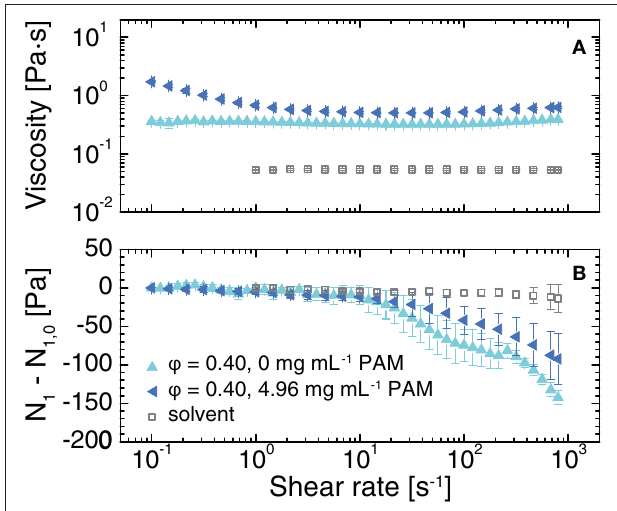
FIGURE 7 | (A) Viscosity and (B) corrected first normal stress difference N 1 − N 1,0 as a function of shear rate for suspensions with φ = 0.40 in 80 (w/w)% glycerol in water, 20.1 ± 0.1 mM NaCl, and the indicated concentration of polymer. The open squares indicate the measured rheological properties of the solvent. Error bars indicate standard deviations over at least 3